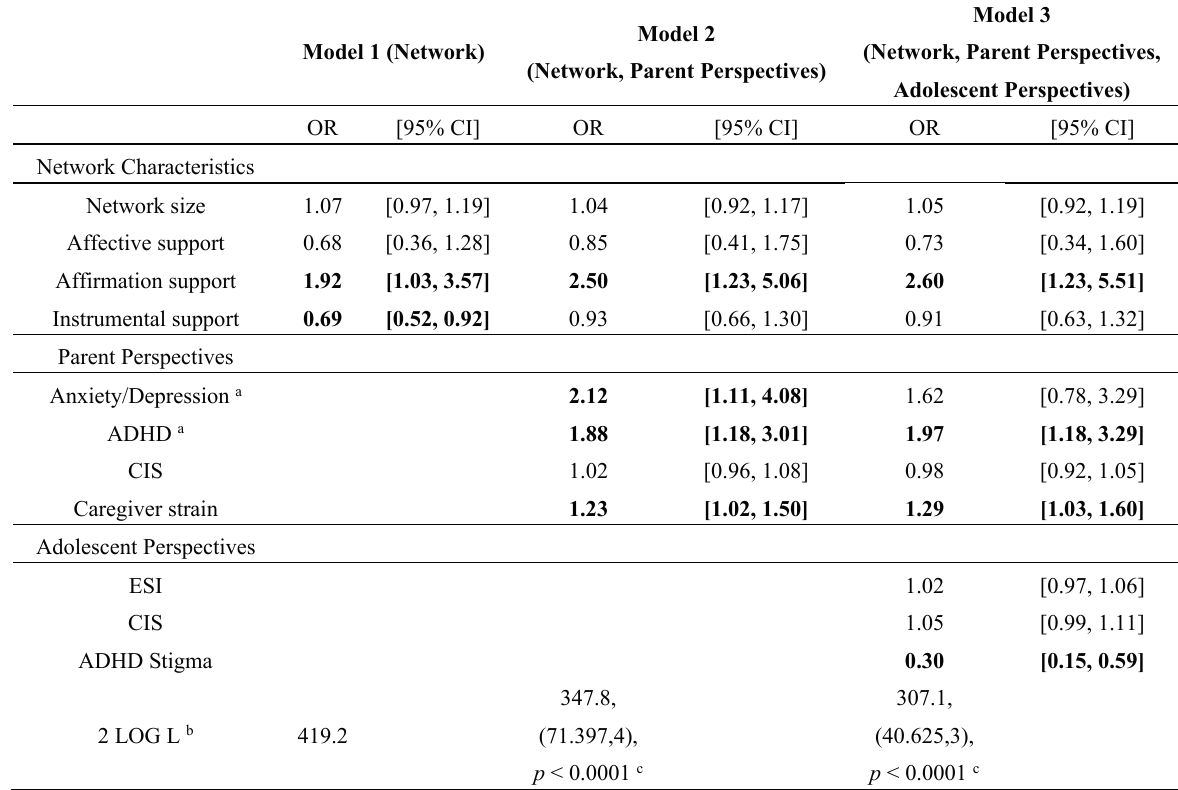
Table 3. Predictors of Mental Health Treatment Use in Past 12